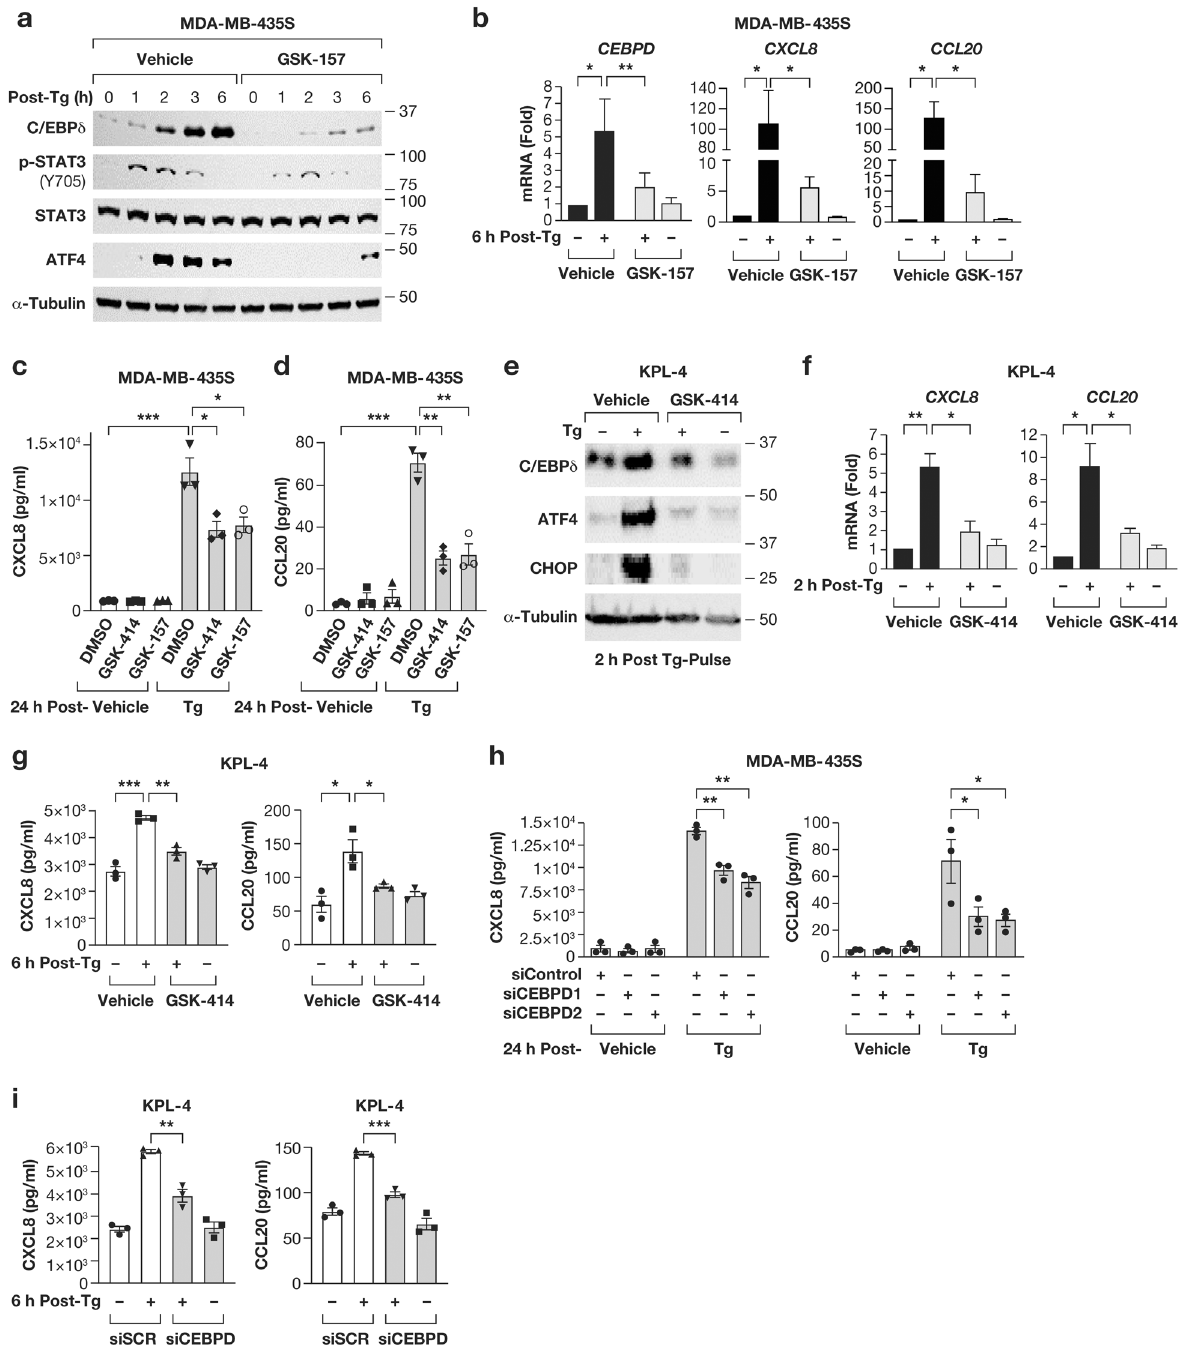
Fig. 7 PERK and C/EBP δ contribute to chemokine expression following ER stress. a Western blot analysis of the indicated proteins from MDA-MB-435S cells collected at the indicated times after pulse-treatment with 100 nM Tg for 30 min with or without pre-treatment with GSK- 157 (10 µM). b qRT-PCR analysis of CEBPD , CXCL8 and CCL20 mRNA level in MDA-MB-435S cells 6 h after pulse-treatment as in a . c, d ELISA for c CXCL8 and d CCL20 in 24 h conditioned media of MDA-MB-435S cells pulse-treated as in a . e Western blot analysis of indicated proteins from KPL-4 cells 2 h after pulse-treatment with 100 nM Tg with or without 30 min pre-treatment with 1 µM GSK-414. f qRT-PCR analysis of CXCL8 and CCL20 mRNA level from KPL-4 cells treated as in e . g ELISA of CXCL8 and CCL20 in 6 h conditioned media from KPL-4 cells treated as panel e . h ELISA of CXCL8 and CCL20 in 24 h conditioned media from MDA-MB-435S cells transfected with either control siRNA or two independent siRNAs against CEBPD and pulse treated with 100 nM Tg. i ELISA of CXCL8 and CCL20 in 6 h conditioned media from KPL4 cells transfected with either siSCR or si CEBPD and pulse treated with 100 nM Tg. Quantitative data are represented as mean±S.E.M, n = 3, * P < 0.05, ** P < 0.01, *** P <